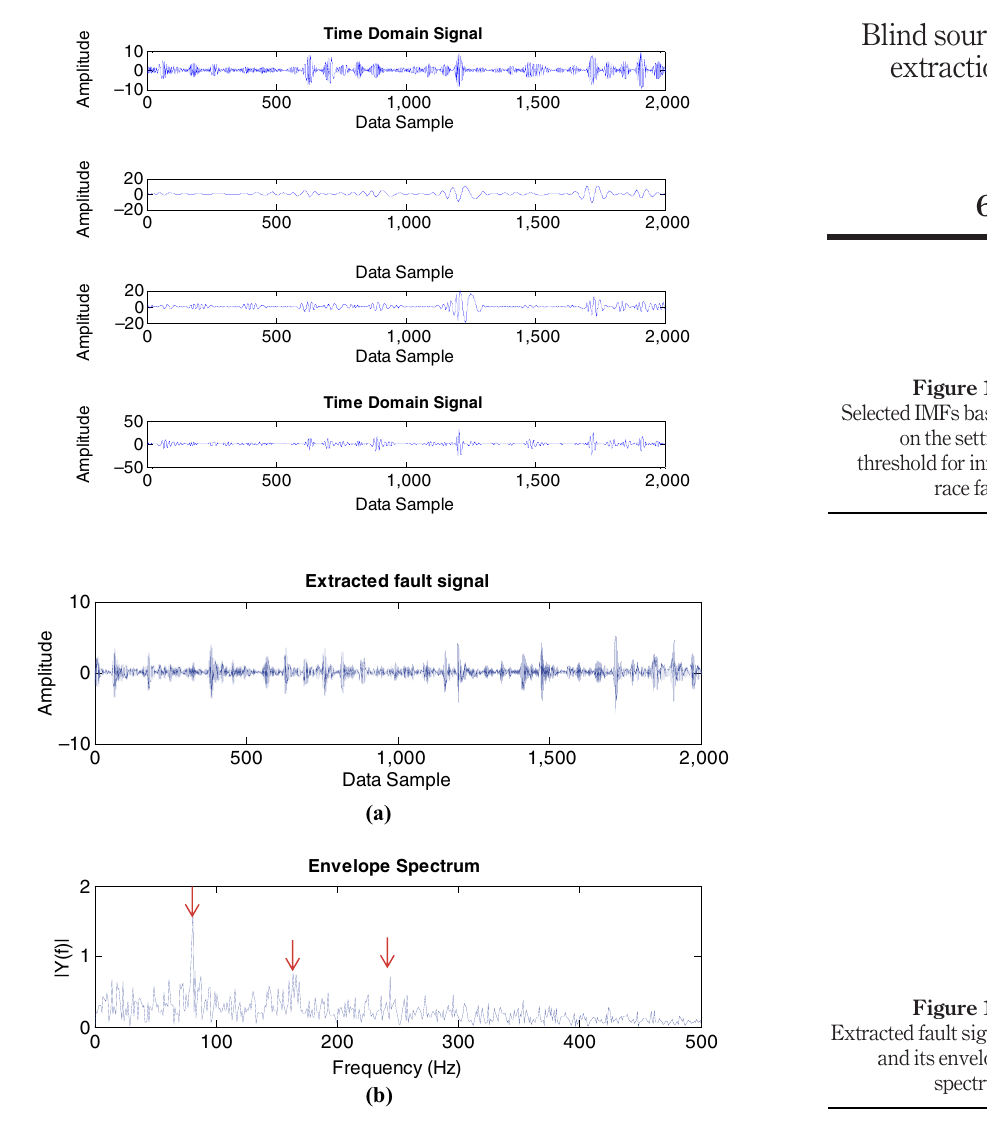
Figure 11. Extracted fault signal and its envelope